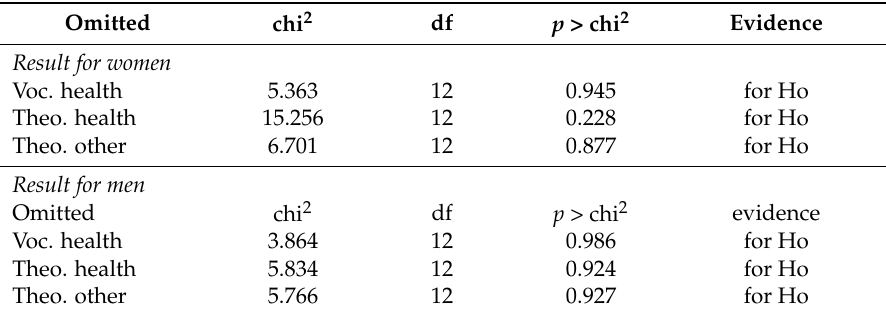
Table A1. Suest-based Hausman tests of the IIA assumption.